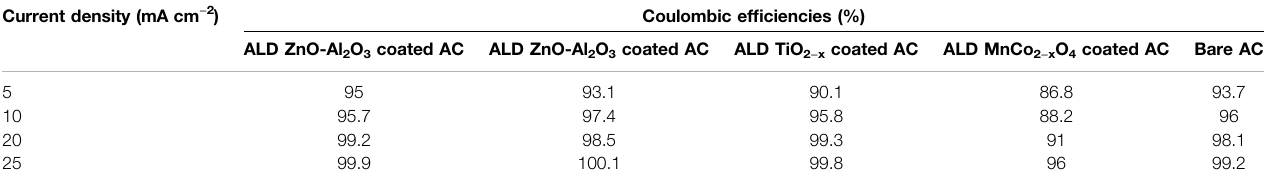
TABLE 4 | Coulombic ef fi ciencies of bare AC and ALD oxide coated ACs at different current densities. Current density (mA cm − 2